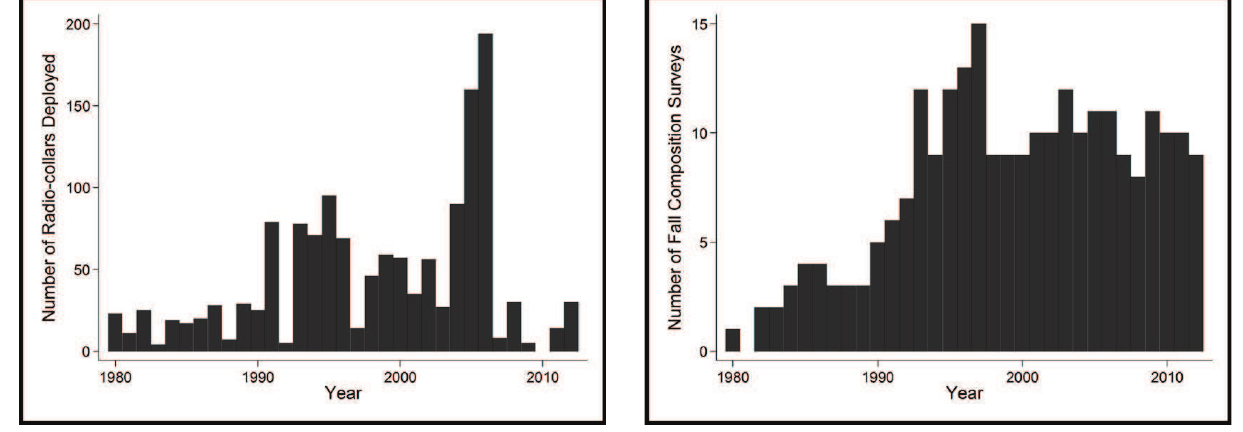
Fig. 3. Number of fall composition surveys conducted on Yukon northern mountain caribou from 1980 – 2012